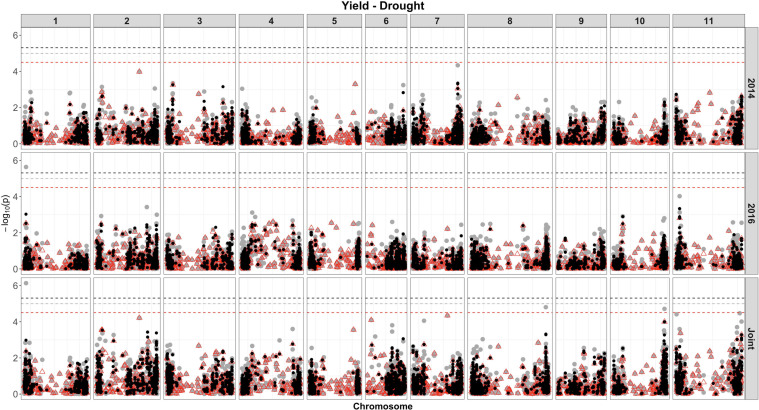
Manhattan plot of the associations for GY, under drought, using a single-based GWAS (gray circle), segment-based GWAS (red triangle), and gene-based GWAS (black circle) based on the role set of experimental data. Gray, red, and black lines indicate Bonferroni-corrected threshold with an experimental type I error rate at α = 0.05.